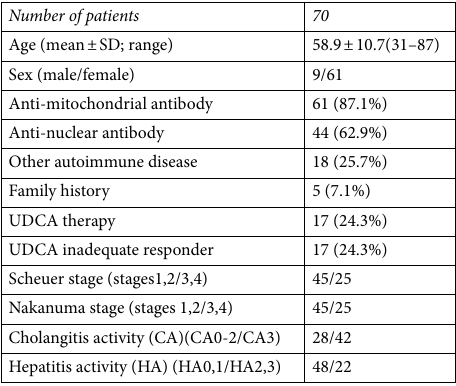
Table 4. Summary of clinicopathological features of patients with primary biliary cholangitis examined. UDCA ursodeoxycholic